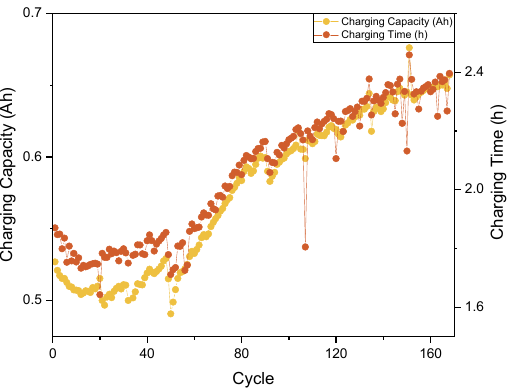
Figure 5. The charging time and capacity profiles of B05 in the CV phase in every cycle.